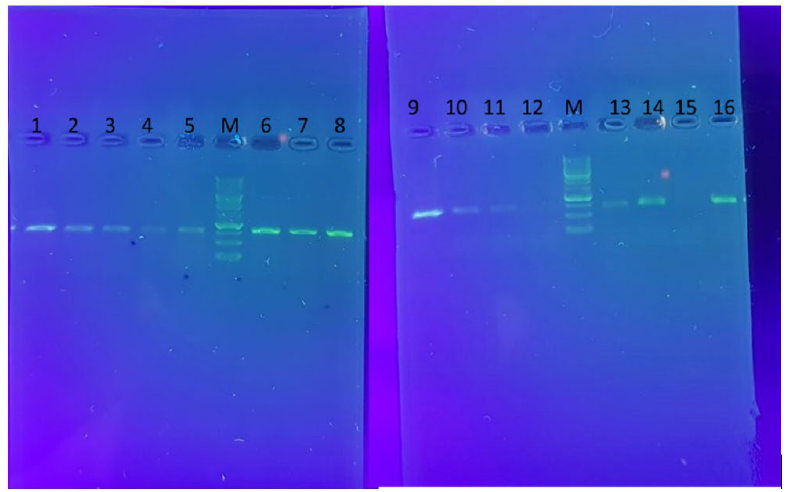
Fig. 1. The amplified sequences of CYP27B1(B) (1,2,3,4,5), VDR (6,7,8) and CYP27B1(A) (9,10,11,13,14,16) through the sequencing- primer PCR method. M; ladder 1KB. Also, 12 and 15 are negative